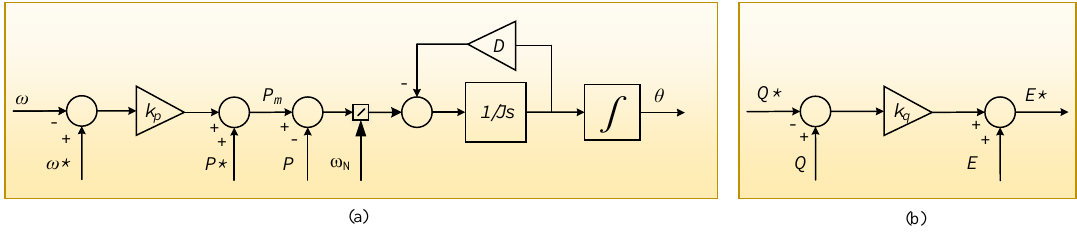
Figure 4. Control scheme: ( a ) virtual synchronous generator (VSG) controller; ( b ) Q − V droop controller.